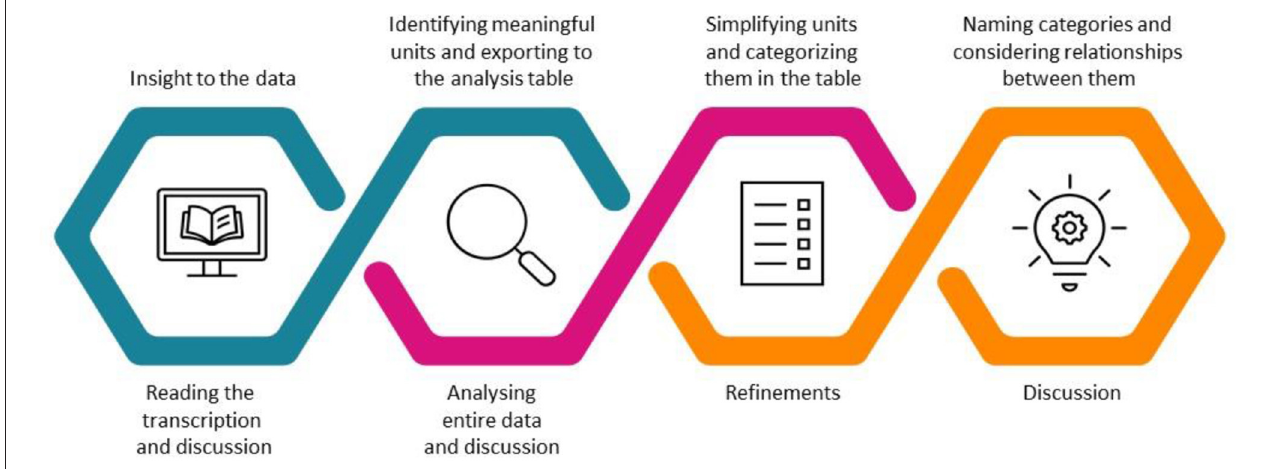
FIGURE 1 | The process of inductive content